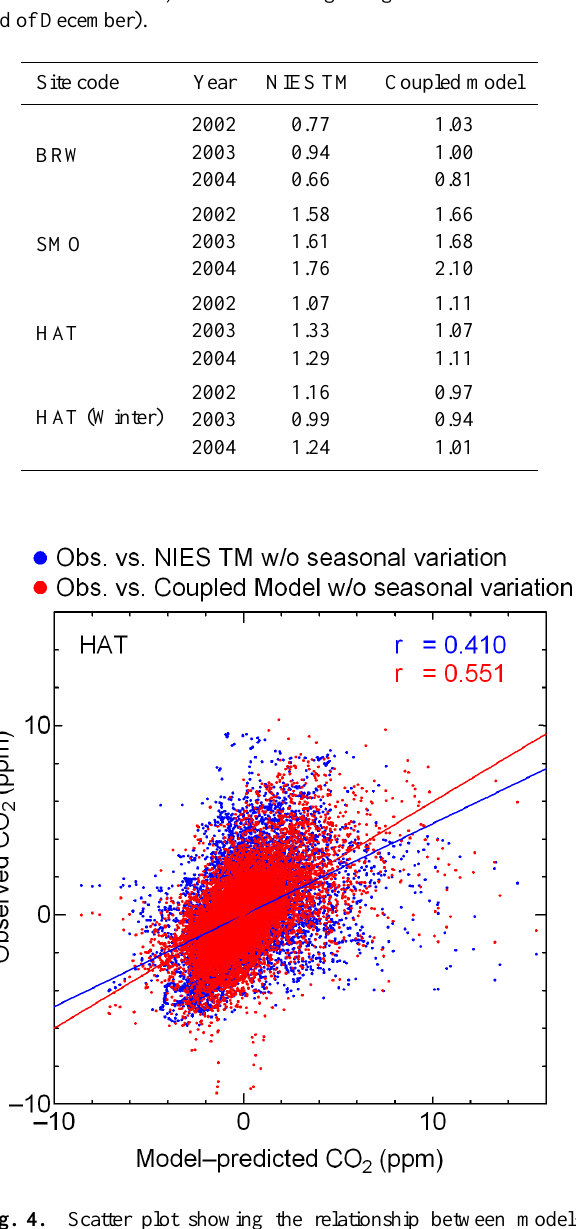
Figure 4. Scatter plot showing the relationship between model-simulated and observed CO 2 Fig. 4. Scatter plot showing the relationship between model- simulated and observed CO 2 concentrations at a synoptic scale for concentrations at a synoptic scale for the period 2002–2004 at Hateruma. Blue circles: NIES the period 2002–2004 at Hateruma. Blue circles: NIES TM versus TM versus observations; red circles: coupled model versus observations. observations; red circles: coupled model versus